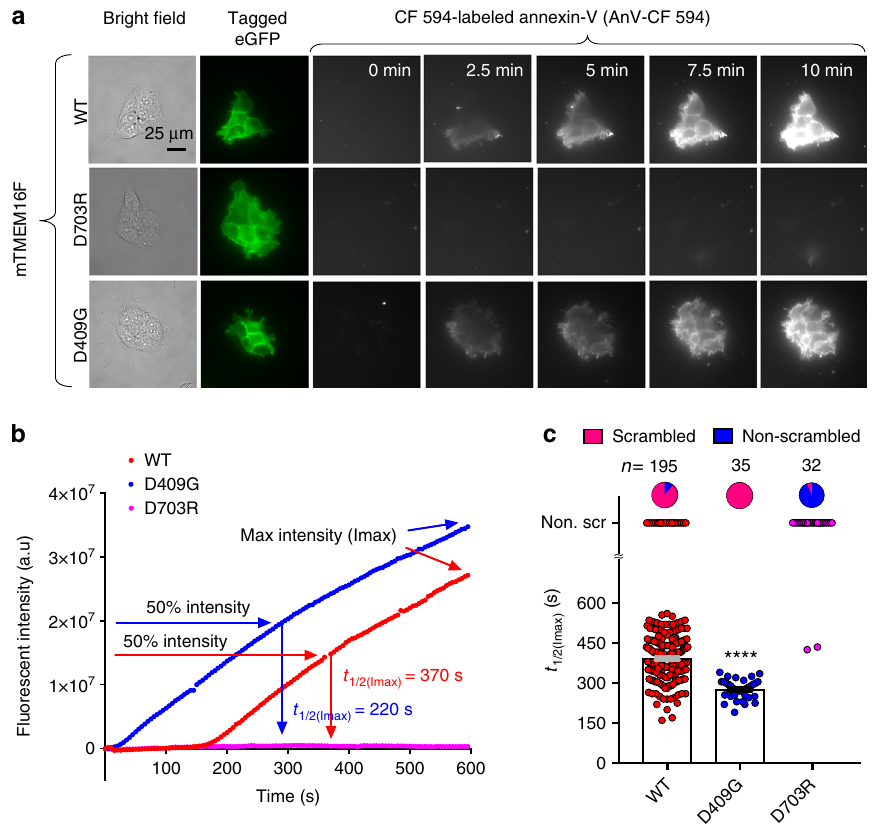
Fig. 2 Quanti fi cation of CaPLSase activity using an Annexin V (AnV)-based imaging assay. a Representative images of ionomycin-induced scrambling activity of TMEM16F-knockout HEK293T cells expressing eGFP-tagged TMEM16F-WT, D409G, or D703R. CF 594-tagged-AnV signal representing phospholipid scrambling was recorded by time-lapsed imaging for 10-min post 5 µ M ionomycin application (0 min) at a 5-s acquisition interval. Scale bars, 25 µ m. b Representative AnV fl uorescent intensity changes for TMEM16F-WT, D703R, and D409G expressing cells in a . t 1/2(Imax) is the time at which